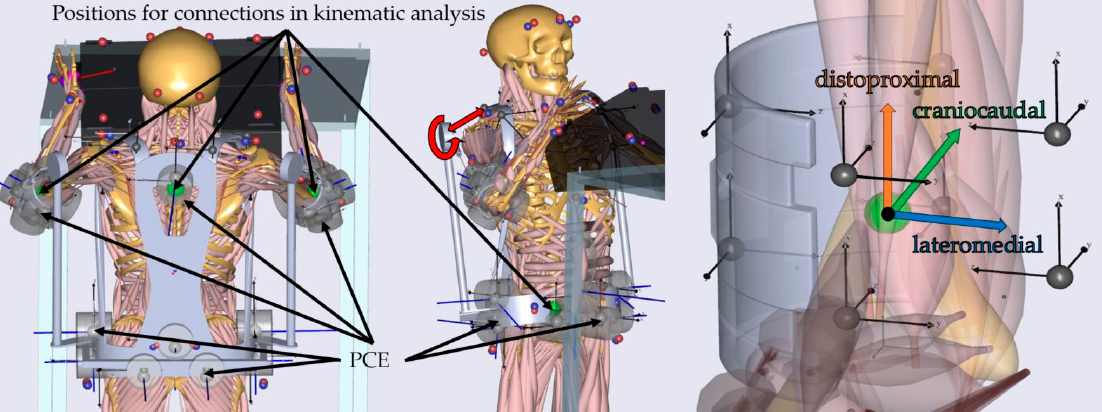
Figure 4. ( Left ): Two different angles from the exoskeleton connected to the human model in the AnyBody Modeling System TM (AMS). The exoskeleton (grey) is connected with the human body model with AnyKinExtraDrivers (positions pictured with green spheres) in the kinematic analysis and with predictive contact elements (PCE, grey transparent cylinders) in the inverse dynamic analysis. They are positioned at the arms (16 elements), hip (10 elements), and back (one element). Arrows show exemplary positions of PCE at the sides, front, and back of the hip belt, the back, and the arm bracings. Blue lines show normal and friction forces currently acting on the PCE. Torques generated by the torque ‐ generating joints and spring forces between the back plate and torque ‐ generating joints are depicted with red arrows. ( Right ): Arm and Arm bracing (transparent) with coordinate system defined in its center with three axes: the distoproximal axis (along the arm longitudinal axis), the craniocaudal axis (points to the bottom when shoulder flexion is 90°) and the lateromedial axis (points to the sagittal plane when shoulder abduction is zero). The position of the AnyKinExtraDrivers is in the center of the coordinate system (green sphere). Positions of the PCE are illustrated by eight black coordinate systems around the arm bracing.